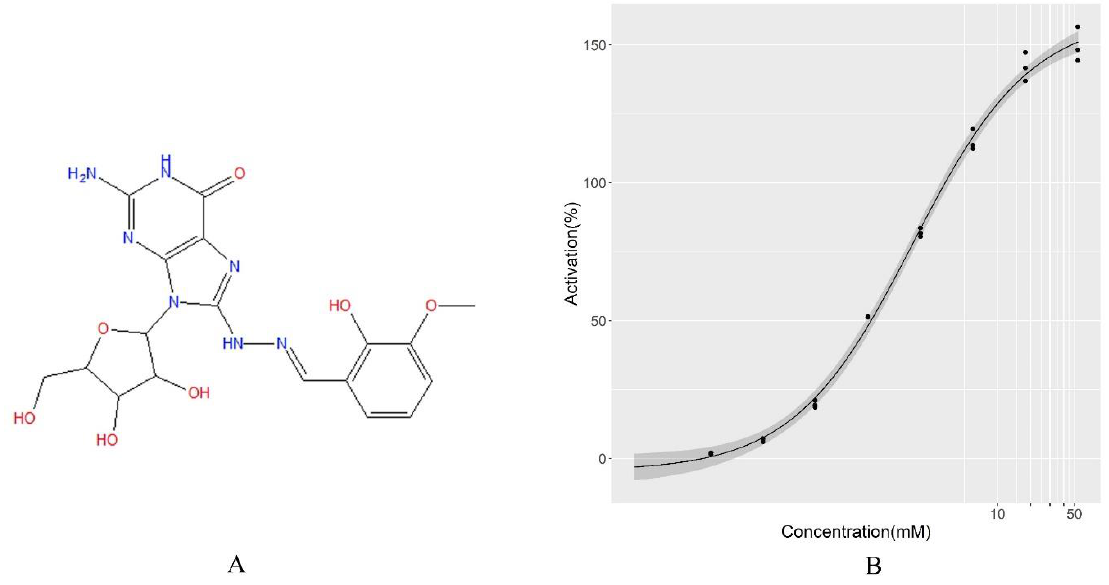
Figure 6. Chemical information of MCULE-2245265974. ( A ) Chemical structure of MCULE-2245265974. ( B ) Dose–response curve of MCULE-2245265974. The corresponding value of EC 50 is 0.71 µM.